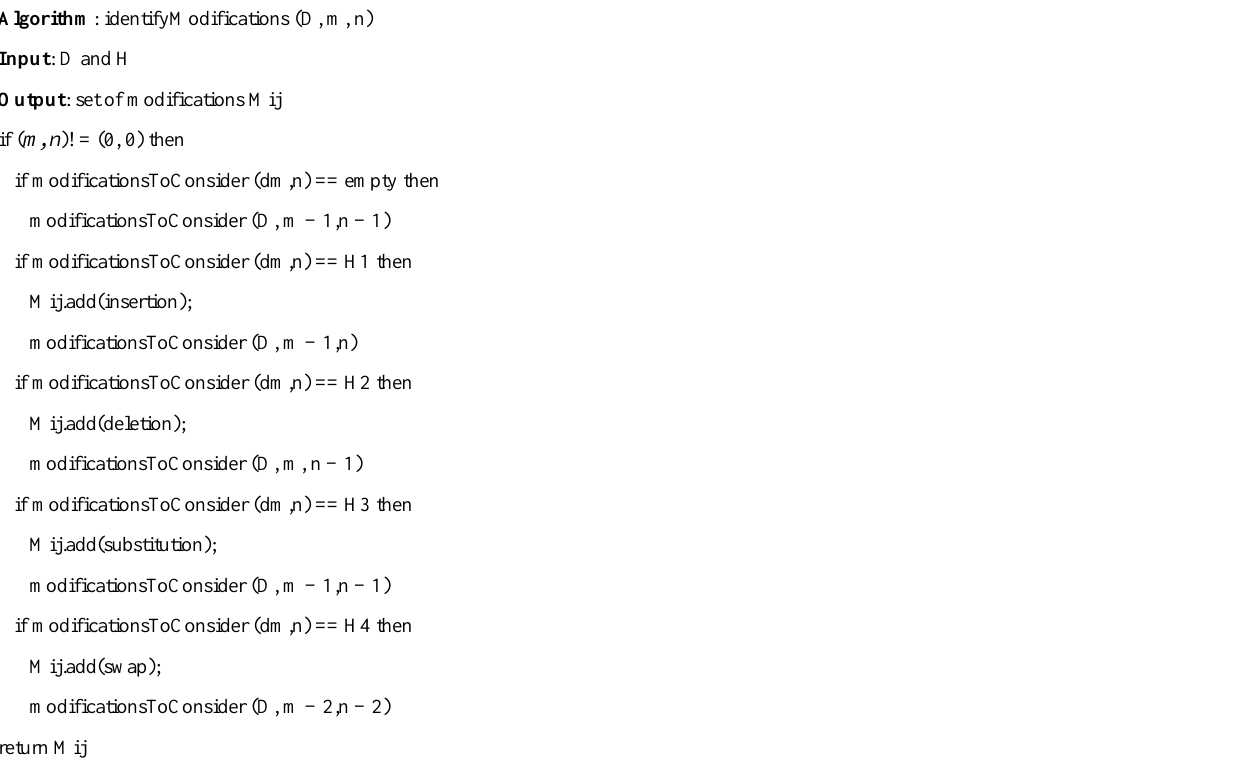
the algorithm identifyModifications (D, |C|, | ρ ij|) (see Textbox 3. Textbox 3. Identifying Modifications Based on Distance